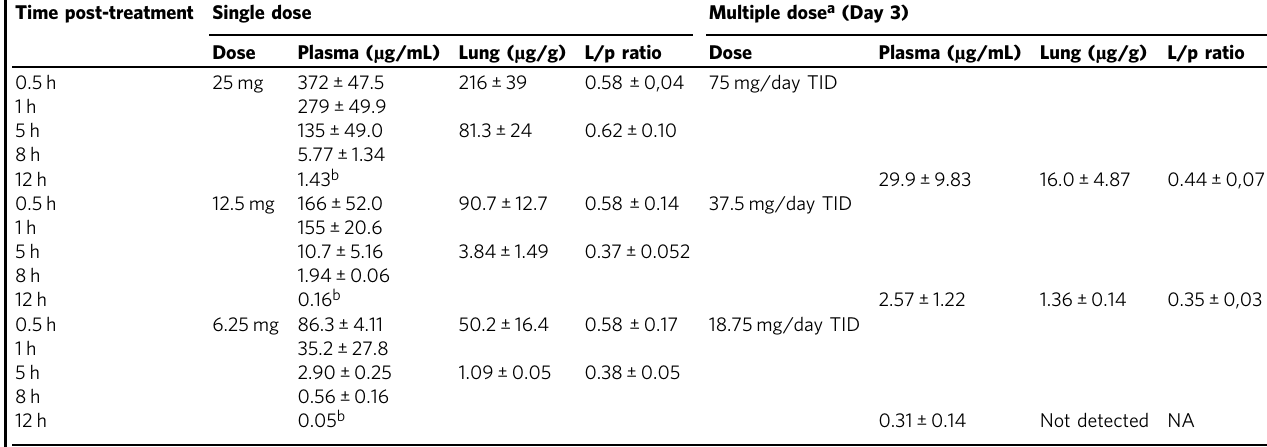
Time post-treatment Single